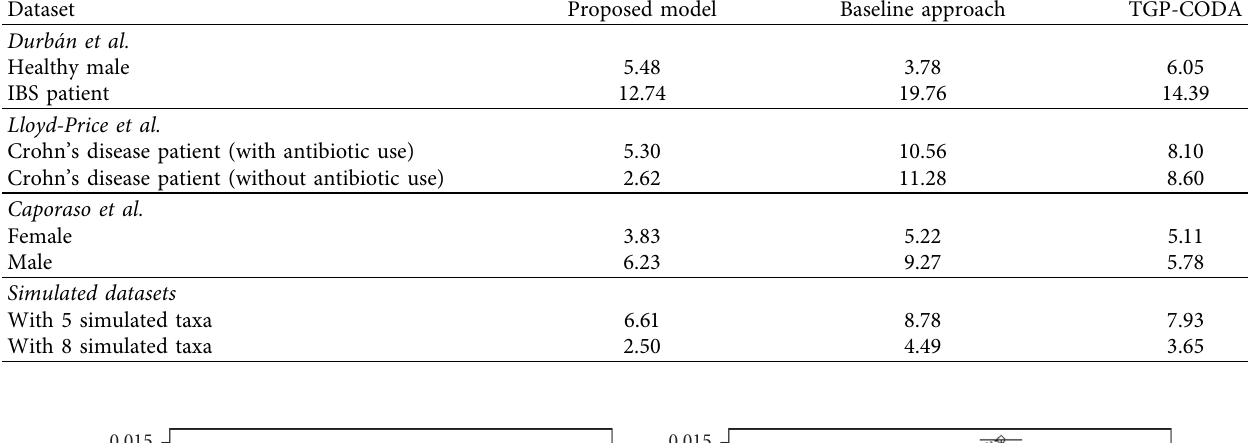
Table 2: Predictive efficiency. The sum of absolute errors (SAE × 10 1 ) is shown.